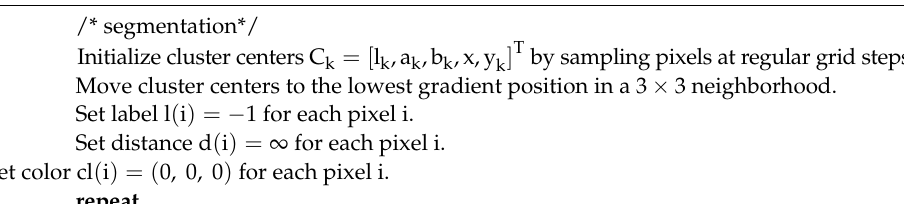
Algorithm 1 Color Mean Segmentation